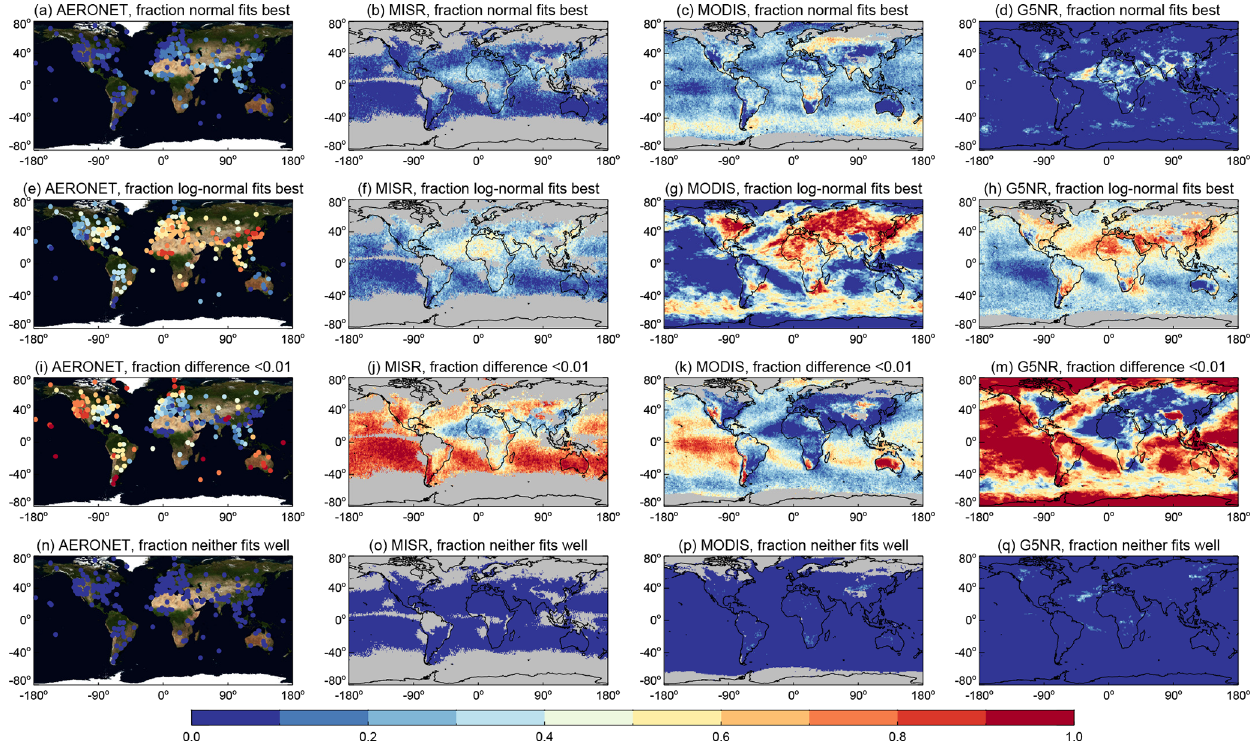
Figure 7. As in Fig. 3 except for AOD distributions aggregated temporally from daily to monthly. Columns show (from left to right) AERONET, MISR, MODIS, and G5NR data. Except for G5NR, at least 16 contributing months are required for an AERONET site or grid cell to be valid; grid cells with insufficient data are shaded in